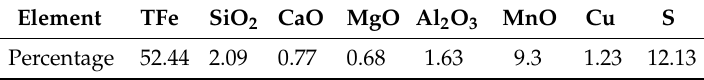
Table 4. Chemical compositions of compound additive (wt. %).